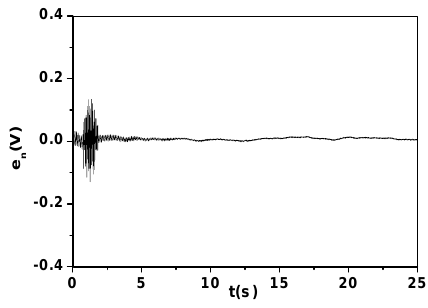
Fig. 8. Error evolution – NLMS algorithm applied to case C 2 .